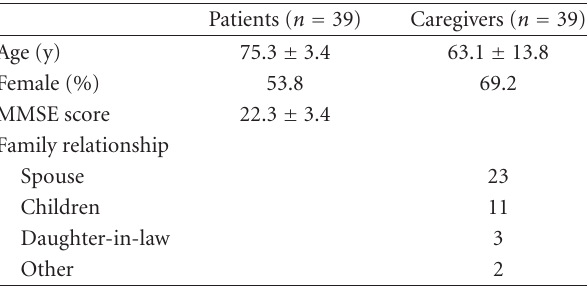
Table 1: Demographics of patients and caregivers. Patients ( n =